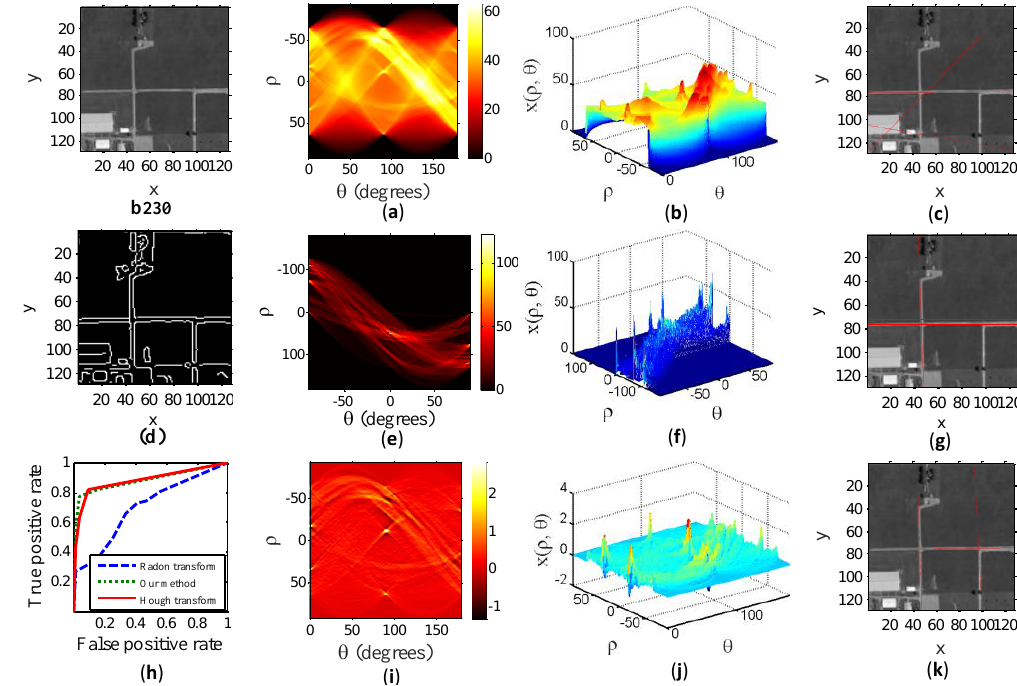
Figure 9. b230 is a test image. ( a ) Radon transform of test image in two-dimensional parameter space. ( b ) Three-dimensional form of ( a ). ( c ) Detected line from ( b ) overlaid on test image. ( d ) Binary image of the test image. ( e ) Hough transform of ( d ). ( f ) Three-dimensional form of ( e ). ( g ) Detected line from ( f ). ( h ) Receiver Operator Curves of the evaluated detection methods. ( i ) Transform image obtained by our method. ( j ) Three-dimensional form of ( i ). ( k ) Detected line from ( j ). Table 2. Time-consuming comparison of two methods.